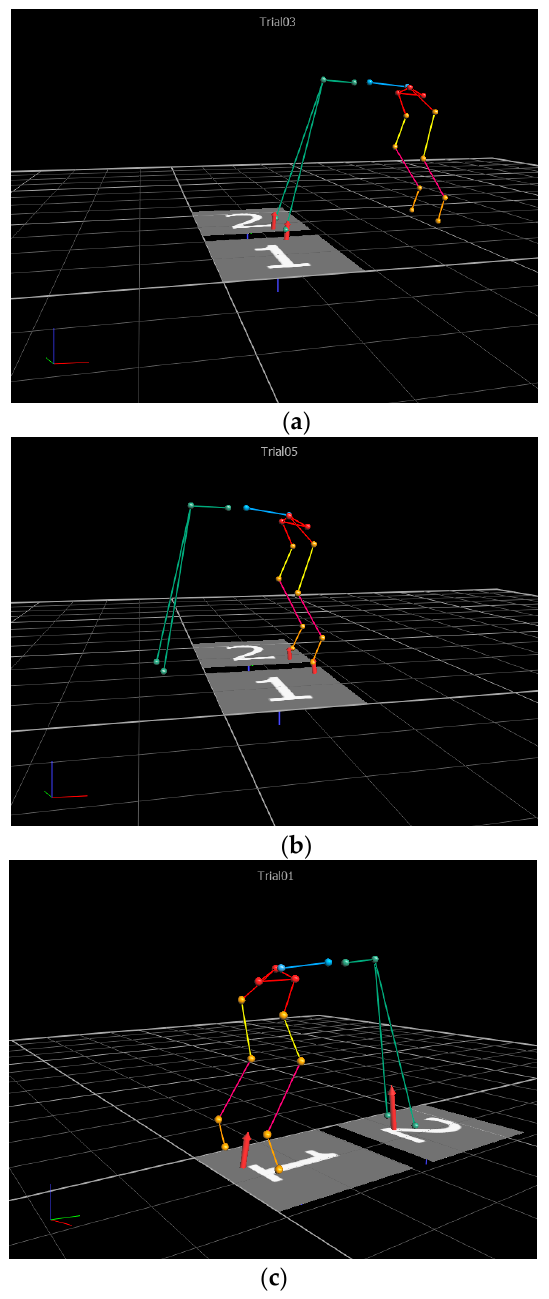
Figure 3. Force platform acquisitions and screenshots on static acquisitions from the Vicon Nexus’ software: ( a ) left and right forelimb paws on platforms 1 and 2, respectively; ( b ) left and right hind limb paws on platforms 1 and 2, respectively, ( c ) left and right hind paws on platform 1 and left and right for paws on platform 2.